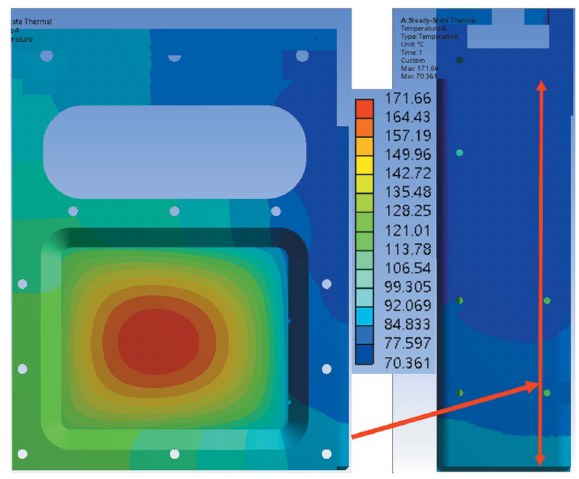
Figure 14 Numerical simulation results for temperature distribution of the foil carrier and copper contact pad with a contact area of 80%.